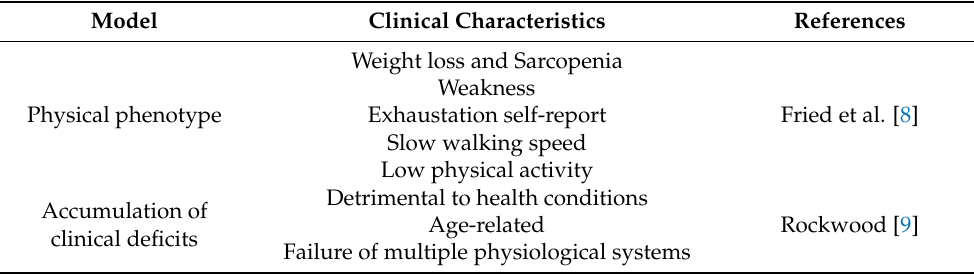
Table 1. Identification of clinical characteristics of frail patients by model